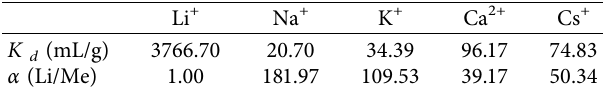
Table 2: Selectivity of the spheres CMC-LTO-EGDE-ME in geothermal water.